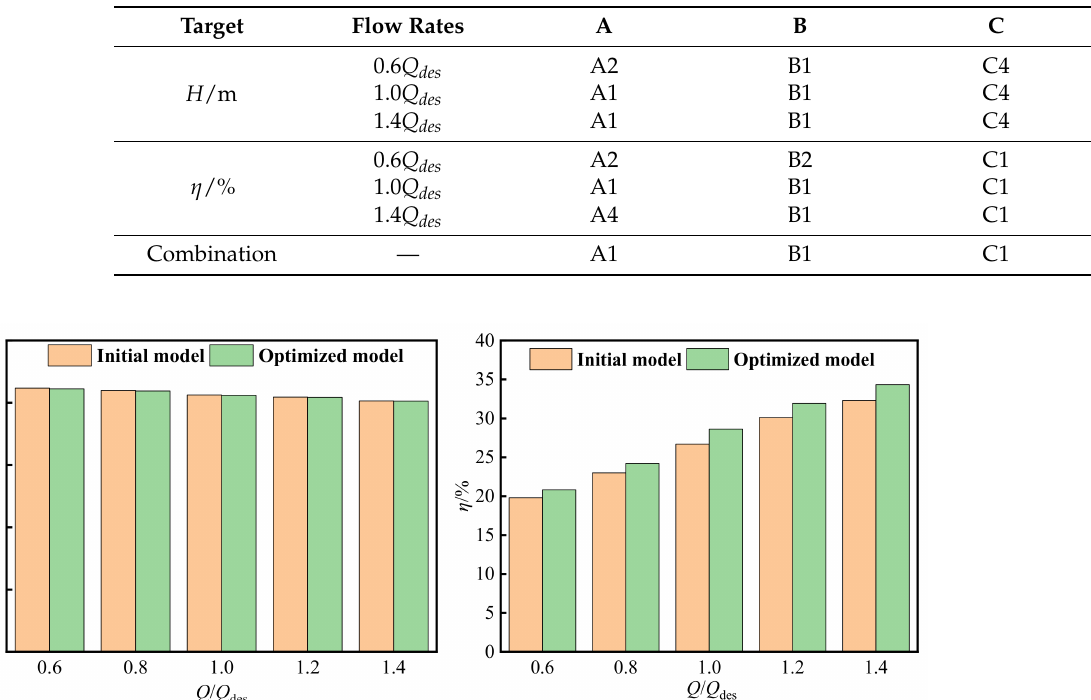
Figure 8. Performance of the optimal solution compared to the original